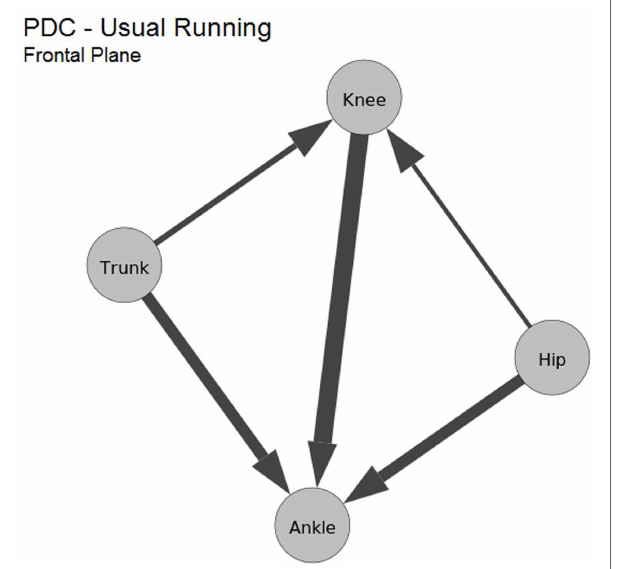
FIGURE 4 | Causal influence in the kinematic data during the running of one subject, in the frontal plane. The nodes are the 3D kinematic joints. Each edge represents the maximum PDC computed between the joints.